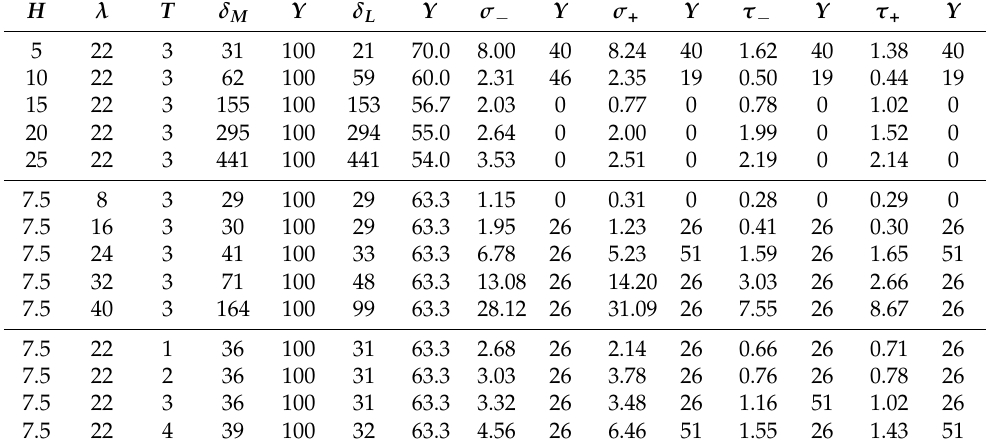
Table 6. Values and positions ( Y = % H from base to top) of maximum deflection ( δ M ) and deflection in the horizontal load ( δ L ) position (mm), maximum negative ( σ − ) and positive ( σ + ) normal stresses (MPa), and maximum negative ( σ − ) and positive ( σ + ) shear stresses (MPa) for the height ( H ), slenderness ( λ ), and taper ( T × 10 2 ) values adopted in each of the simulated scenarios. Horizontal load 15